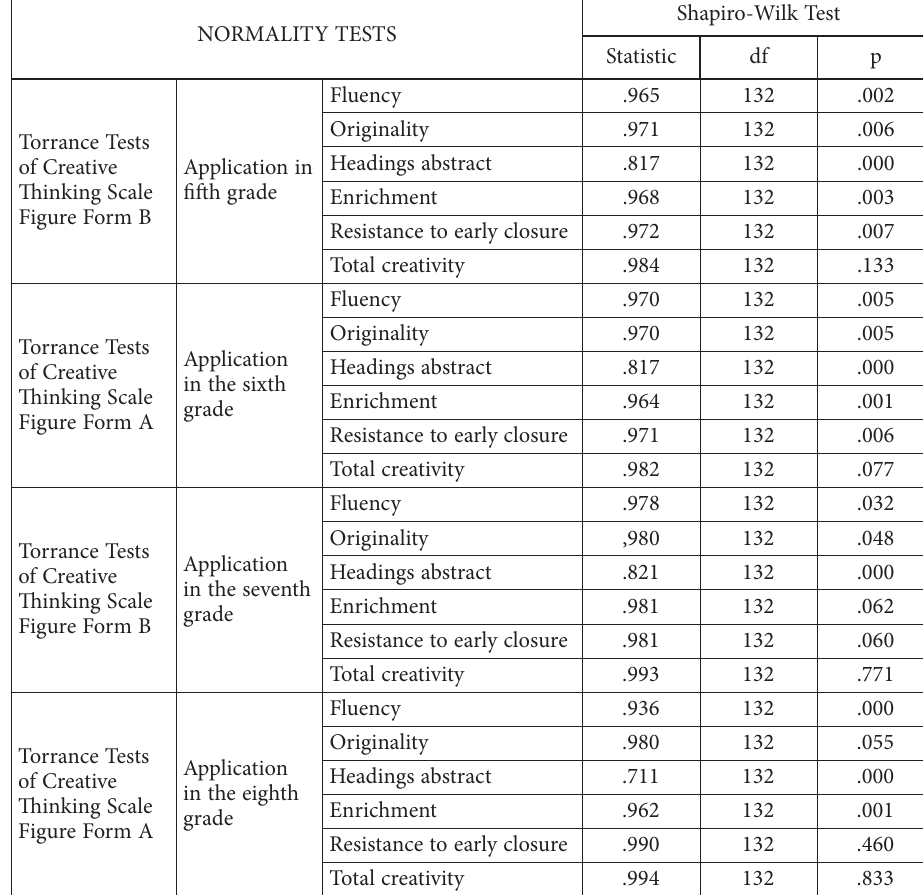
Table 3. Torrance Tests of Creative Thinking Scale Figure Form A and subdimension scores normality analysis (source: created by